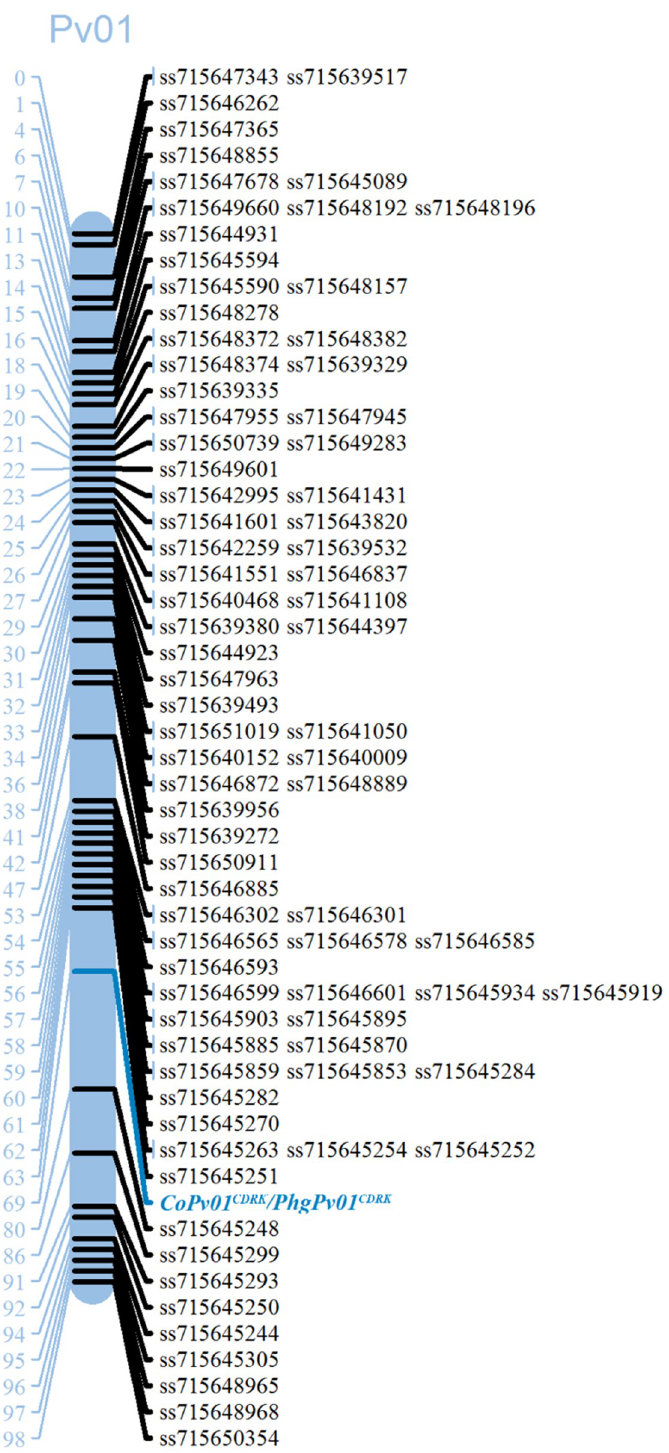
Fig 1. Genetic map of common bean linkage group Pv01 containing the anthracnose and angular leaf spot resistance loci and linked Single Nucleotide Polymorphism (SNPs) markers used to genotype the F 10 population California Dark Red Kidney × Yolano. Recombination distances are indicated on the left side of the linkage group in centiMorgans (cM), and the marker names are shown on the right side. The CoPv01 CDRK /PhgPv01 CDRK resistance loci were flanked by SNP markers ss715645251 and ss715645248 in F 10 mapping population. The map was drawn with MapChart (65).